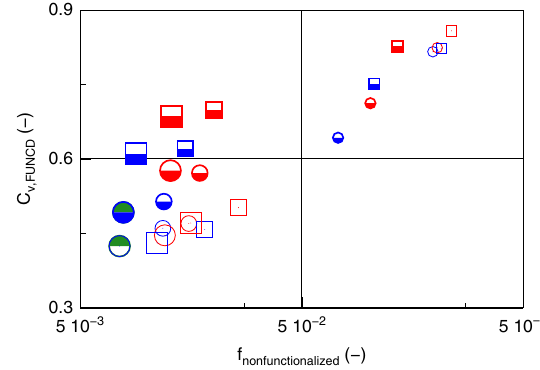
Fig. 9 Summary of the effect of the batch reaction parameters on the fraction of non-functionalized chains ( f nonfunctionalized ) and the coef fi cient of variation ( C v,FUNCD ; Equation (2)). This is illustrated for CROP of a functional and a non-functional monomer (total monomer concentration: 3 mol L − 1 ; solvent acetonitrile; overall monomer conversion = 100%; Fig. 24-26 (also table with color coding cf. Figure 7d); in this fi gure larger symbol: higher initial functional loading (from 2 to 10 to 13 mol %); higher temperature (from 100 to 140 °C) by changing from blue to red color; from open symbol with border with red/blue color to half- fi lled symbol with the same color to highlight change from target DP of 100 to 400; circle to square: change from MeOx/C2MestOx to EtOx/C2MestOx; model-based design allows to determine optimal conditions for a given target DP (here thus 100 and 400): highlighted as half green